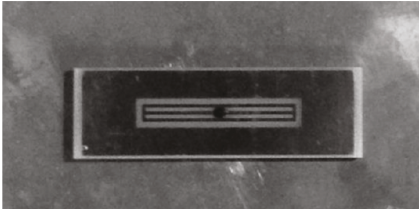
Figure 7: Photograph of the fabricated tag mounting on a copper